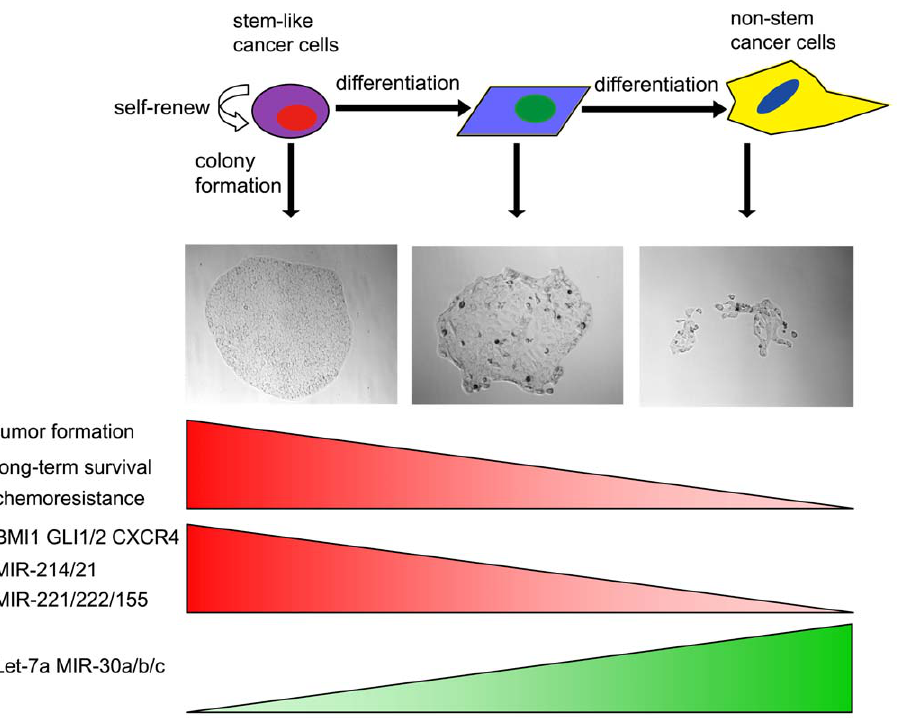
Figure 7. The model of hierarchical organization of pancreatic cancer cell population. The pancreatic cancer stem cells and their progenies in differentiation can develop to single colonies with different morphologies. Based on the in vivo and in vitro characteristics, Holoclones correspond to the cancer stem/progenitor cells, while paraclones correspond to the fully differentiated cells and meroclones correspond to the cells in the intermediate stage. The genes and microRNAs that associate with cancer stem cells and support chemoresistance, including BMI1 , GLI1/2 , CXCR4 , mir-21/214/221/222/155 , are enriched in holoclones. However, the Let-7 and mir-30a/b/c are enriched in paraclones.